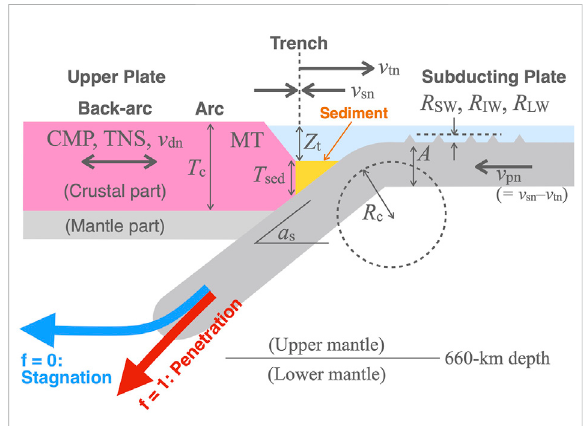
FIGURE 1 Schematiccross-section(perpendicular to the trench axis) of a subduction zone, with the analyzed subduction-zone parameters labeled (Section 2.1 for details). Gray, pink, yellow, and blue regions indicate lithospheric rocks, the upper crust, trench sediments, and seawater,